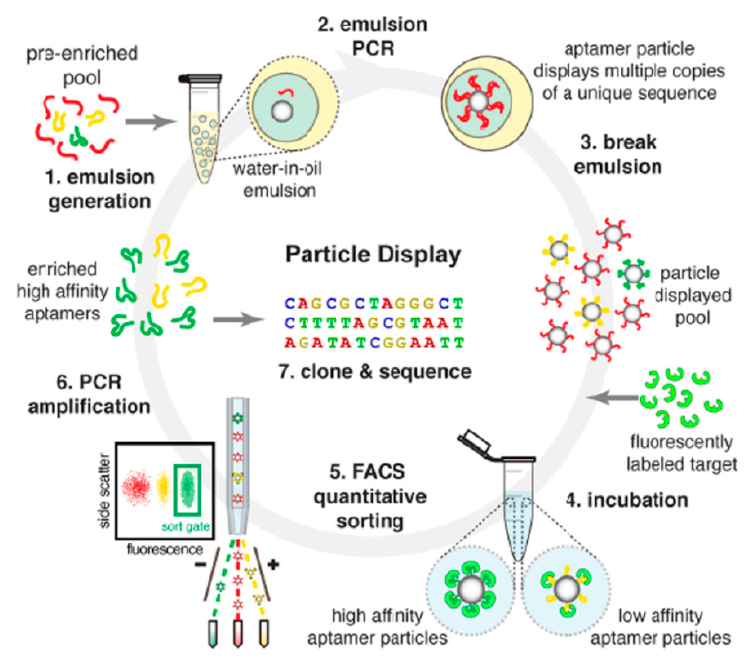
Figure 3. Mechanism of the aptamer particle display system (Reproduced with permission from Reference [29]). Different sequences of ssDNA/RNA are shown in different color.